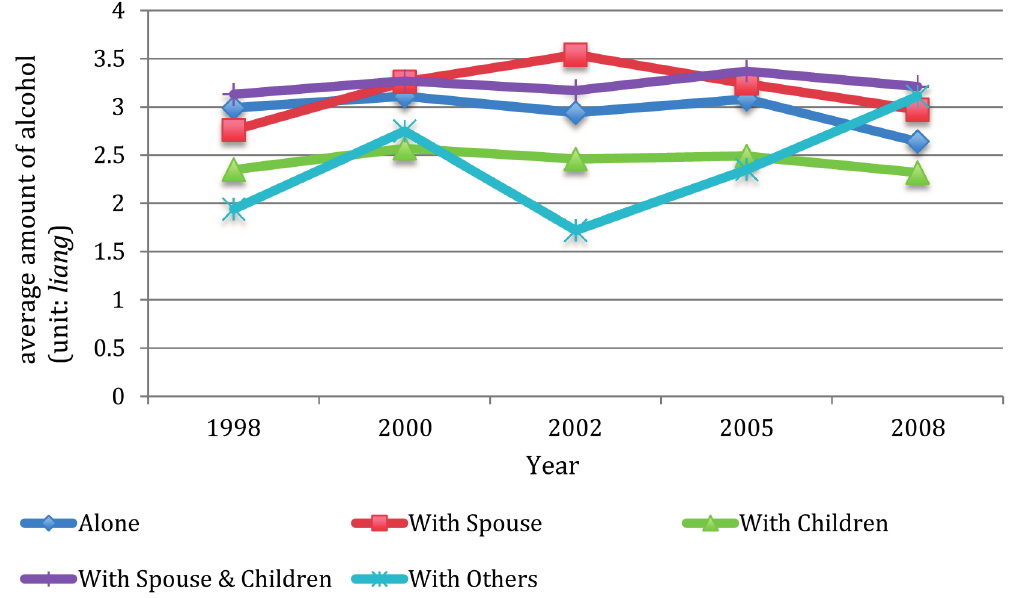
Figure 4. Average amount of alcohol consumed per day among current drinkers by wave and by living